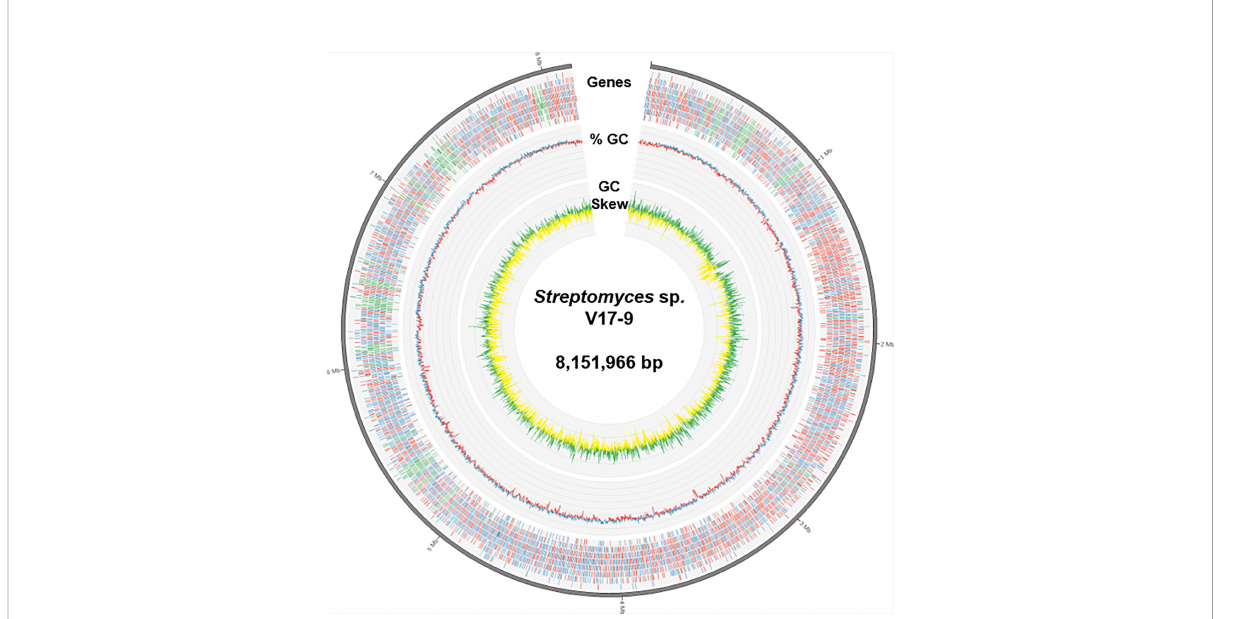
FIGURE 1 A diagram representing genomic features of Streptomyces sp. V17-9. From the outermost track to the center: i) the predicted genes (blue/red for forward/reverse strand and green for BGCs), ii) GC content (blue/red for above/below average), and iii) GC skew (green, >0; yellow, <0). BGCs, biosynthetic gene clusters; GC, guanine –